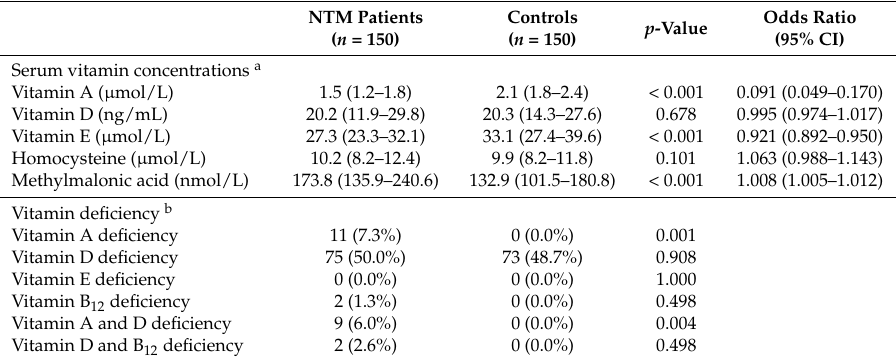
Table 2. Vitamins and vitamin B 12 indicators in the study population.